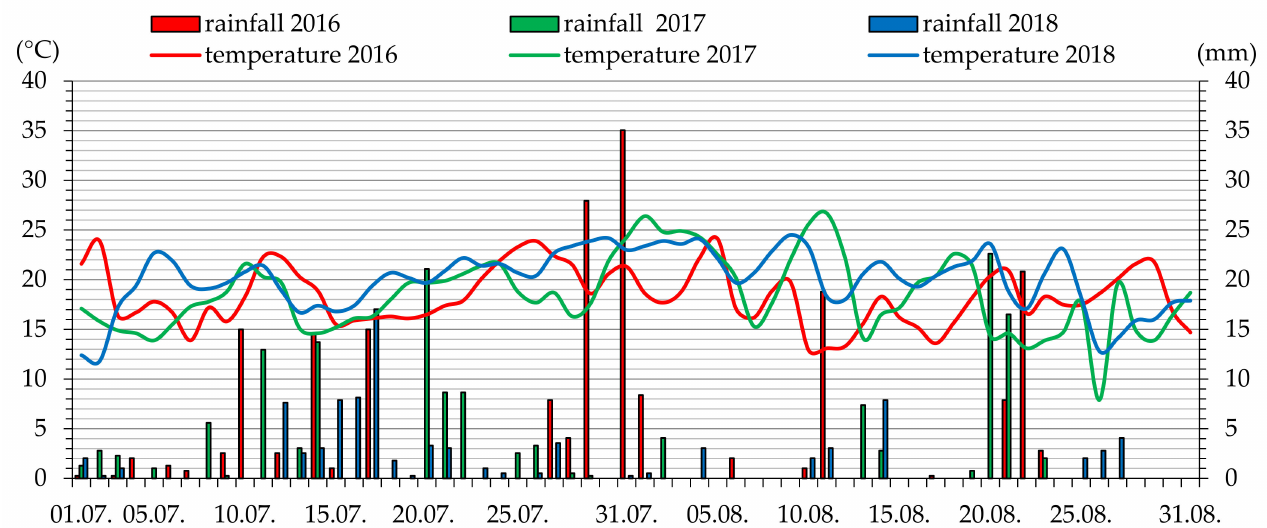
Figure 2. Average daily values of air temperature and precipitation in July and August 2016–2018 in Blin ó w